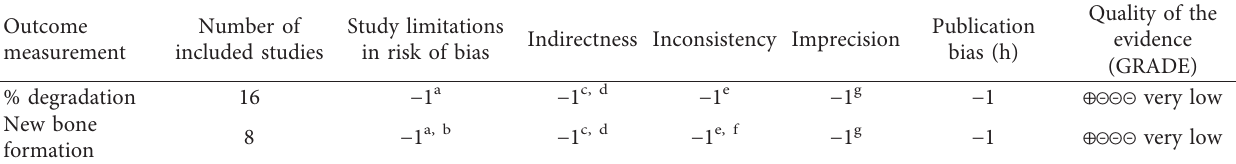
Table 7: Evidence of quantitative results using GRADE